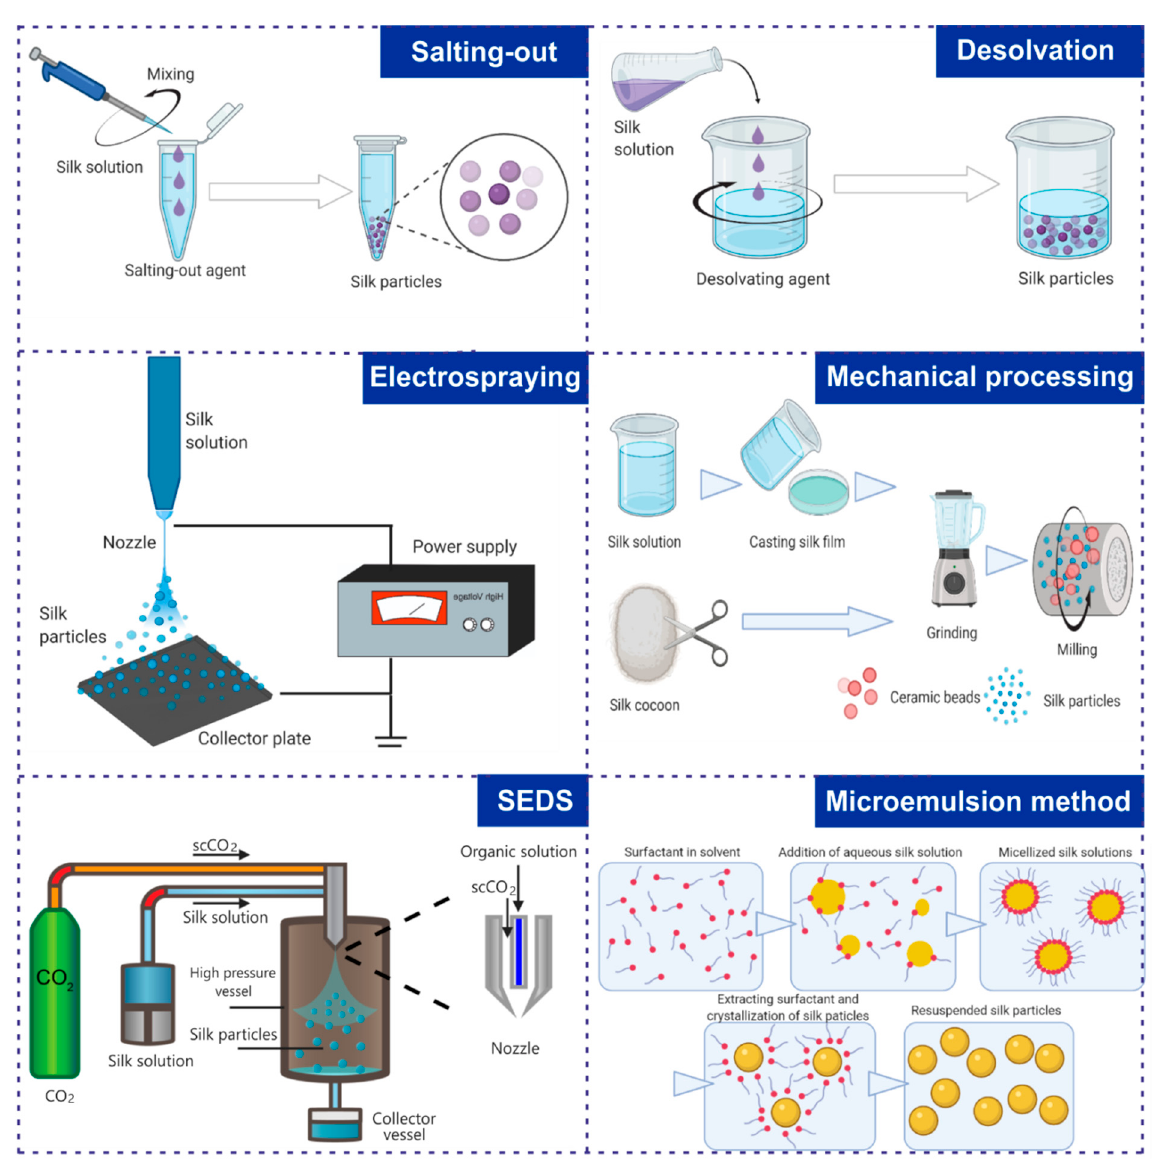
Figure 3. Schematic summary of techniques for the preparation of silk-based nanoparticles. Created with BioRender.com accessed on 28 June 2021.